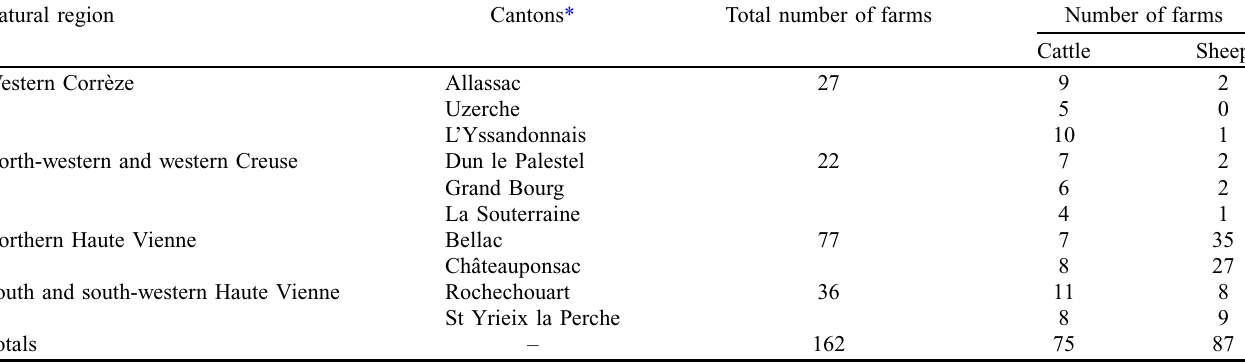
Table 1. Number of cattle- and sheep-breeding farms investigated in the three departments of Limousin in relation to their location in a natural region and the type of breeding.